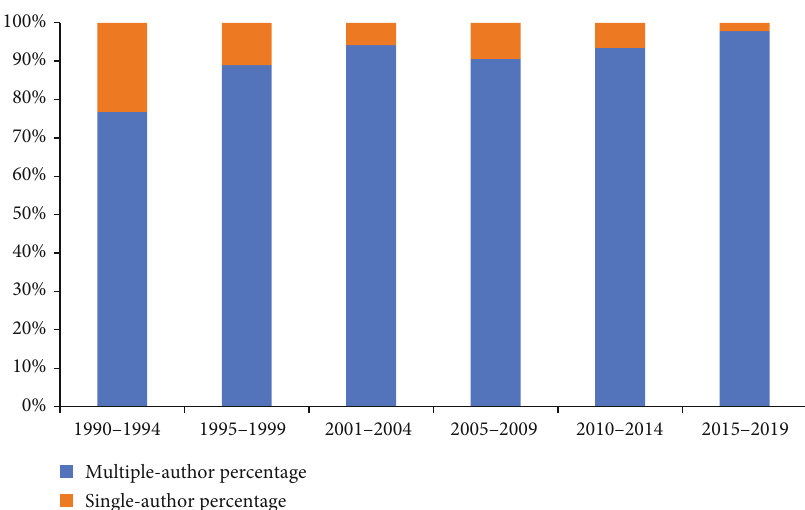
Figure 10: Trends in the percentage of single- vs. multiple-author articles per 5 years.